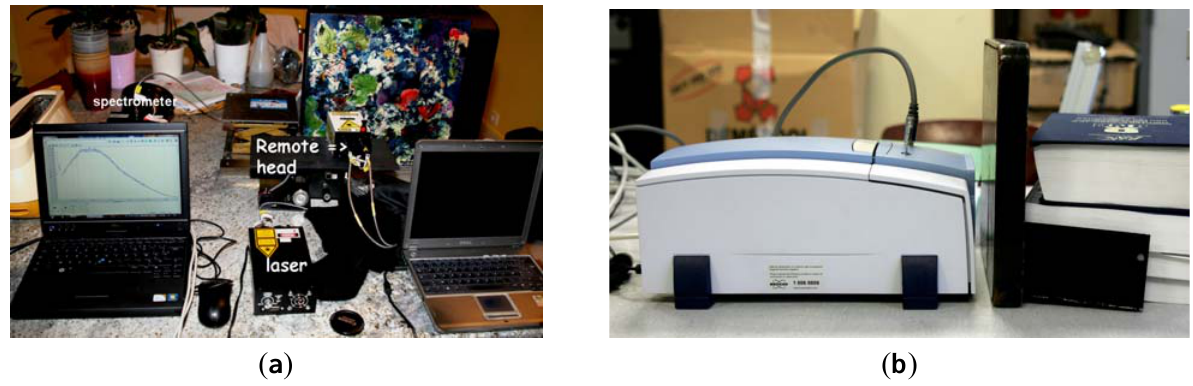
Figure 2. Raman ( a ) and IR ( b ) mobile set-ups.